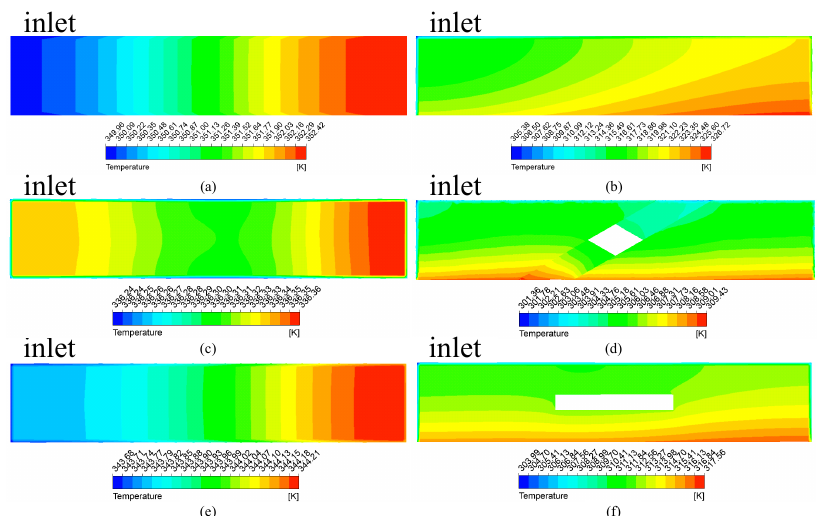
Figure 6. The performance of MC-R, MC-CR and MC-HR when the velocity was 2 m/s. ( a ) The average temperature and the pressure drop; ( b ) the Nu and the equivalent thermal resistance; ( c ) the average convective heat transfer coefficient.